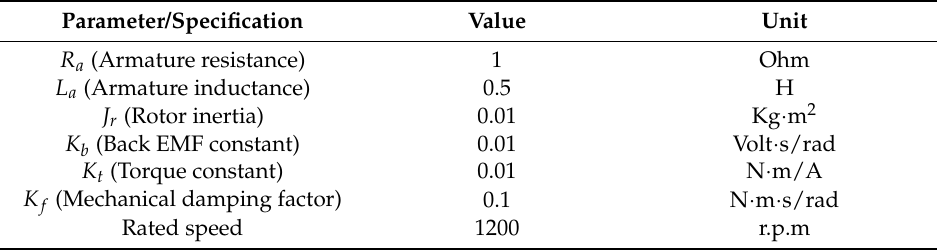
Table 3. DC motor parameters